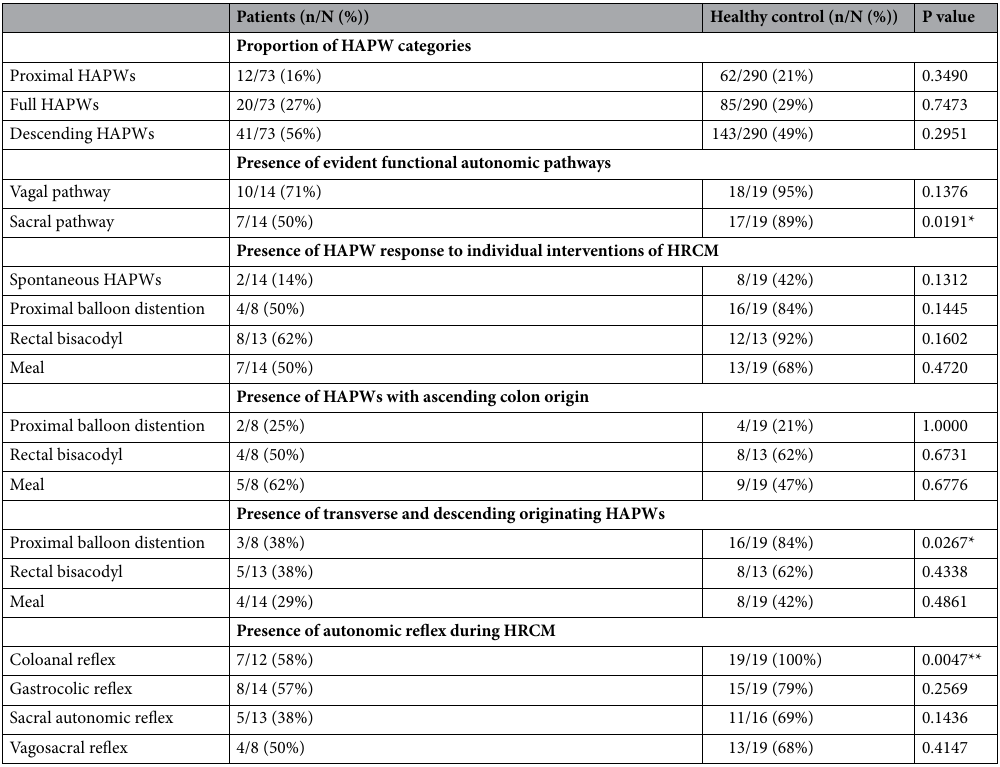
Table 2. Proportion of HAPW categories, occurrence of HAPW response to interventions, and autonomic reflexes during HRCM in chronic constipation patients and healthy subjects. Total number of subjects = N, number of subjects with response = n. P values are reported for the Chi-squared test for the proportion of HAPW categories and the Fischer exact test for the presence of HAPW and autonomic reflex response compared to proportions. The proportion of HAPW category and response data of healthy controls were derived from Milkova et al. 20 . HAPW categories, the number of SPWs, and anal sphincter relaxation were subsequently used to determine the presence of reflexes. *P ≤ 0.05; **P ≤